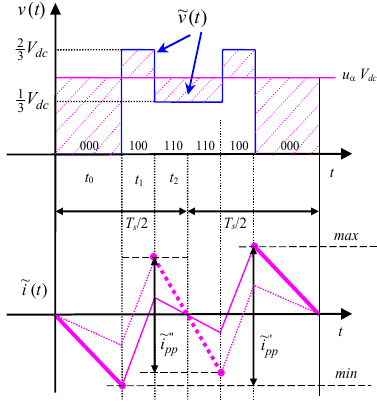
Figure 4. Output voltage and current ripple for DPWM − technique in one switching period (sector I, u α ≥ 1/3).